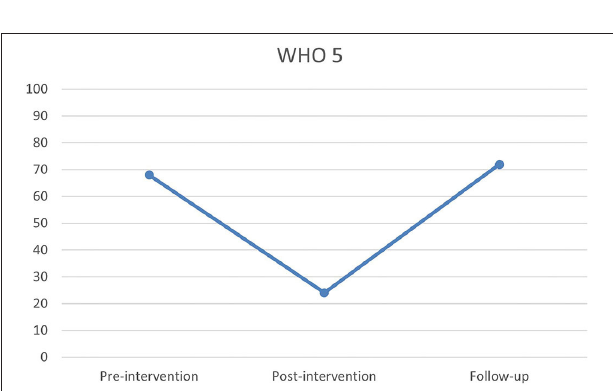
FIGURE 3 | Pre-, post- and follow-up scores on the 5-item World Health Organization Well-Being Index (WHO-5).